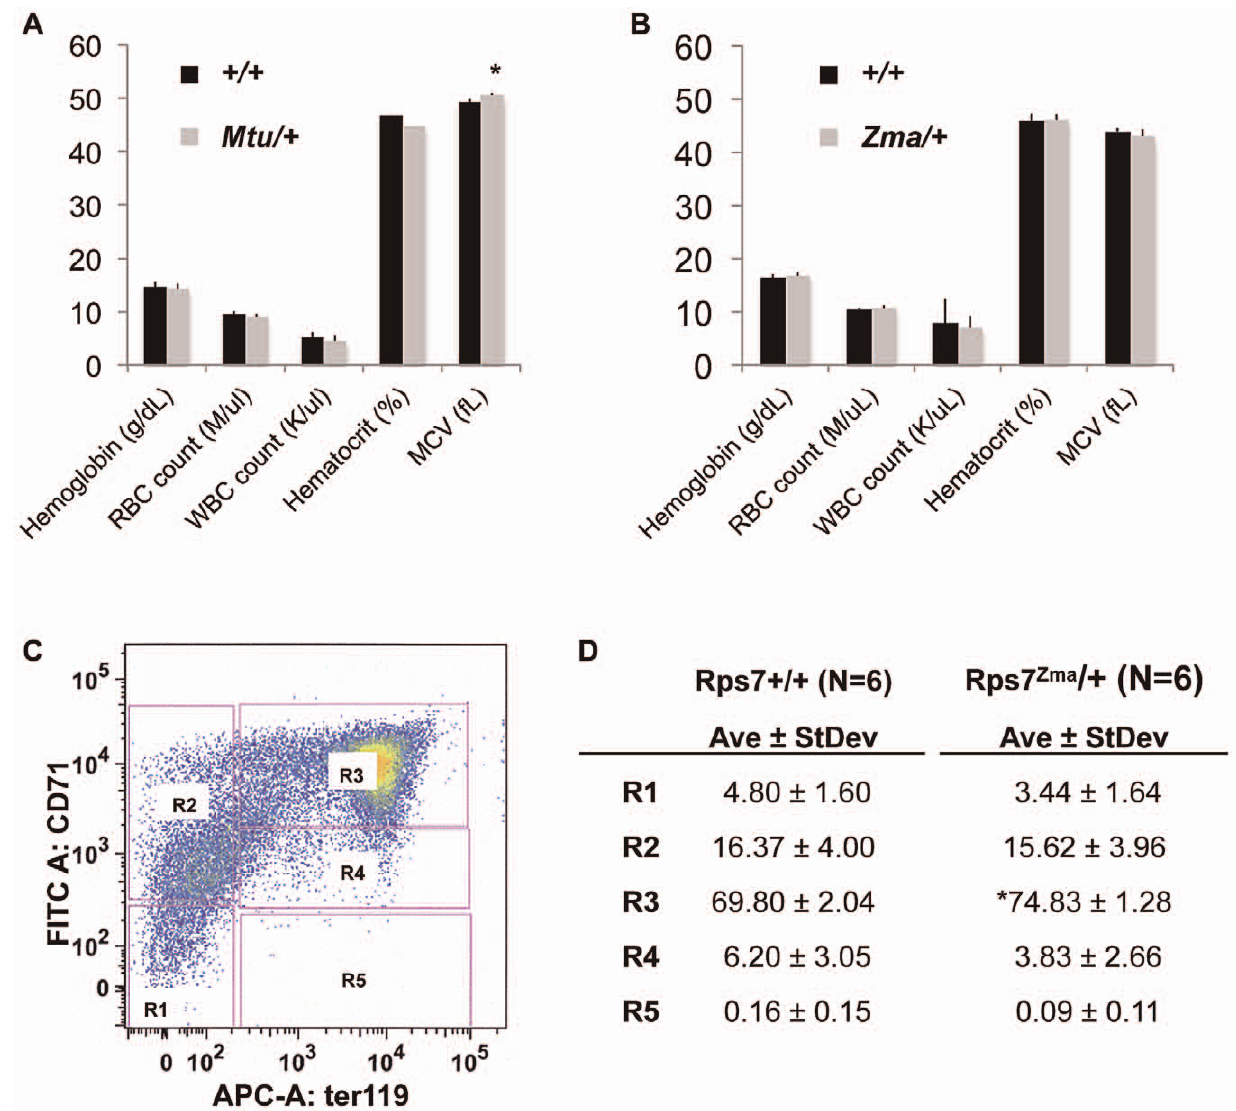
Figure 5. Peripheral-blood parameters appear normal with slight developmental delay in Rps7 Zma / + fetal liver red cell precursors. (A) Rps7 Mtu / + mice displayed similar complete blood count (CBC) values to their wild-type littermates with the exception of a very slightly elevated mean corpuscular volume (MCV) (* indicates p , 0.05; N=7). (B) Rps7 Zma / + mice did not differ significantly from their wild-type littermates in any CBC measurements (N=5). (C) A typical example of FACS analysis of fetal liver cells. The 5 characterized erythroid cell populations, R1–R5, are boxed in pink. (D) The average values and standard deviation for each fetal liver erythroid cell population are given as a percentage of total viable cells in Rps7 + / + and Rps7 Zma / + samples (* indicates p , 0.001;